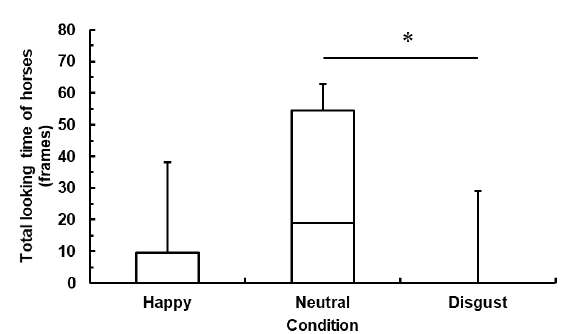
Figure 4. Total looking time of horses. Total looking time of the horses during two gaze-emotional cue presentations per trial of each experimental condition. The maximum total looking time was 180 frames because the experimenter presented each gaze-emotional cue for 90 frames (3 s). The median in each condition was 0 in the Happy condition, 19 in the Neutral condition, and 0 in the Disgust condition (* p < 0.05) (30 frames = 1 sec).